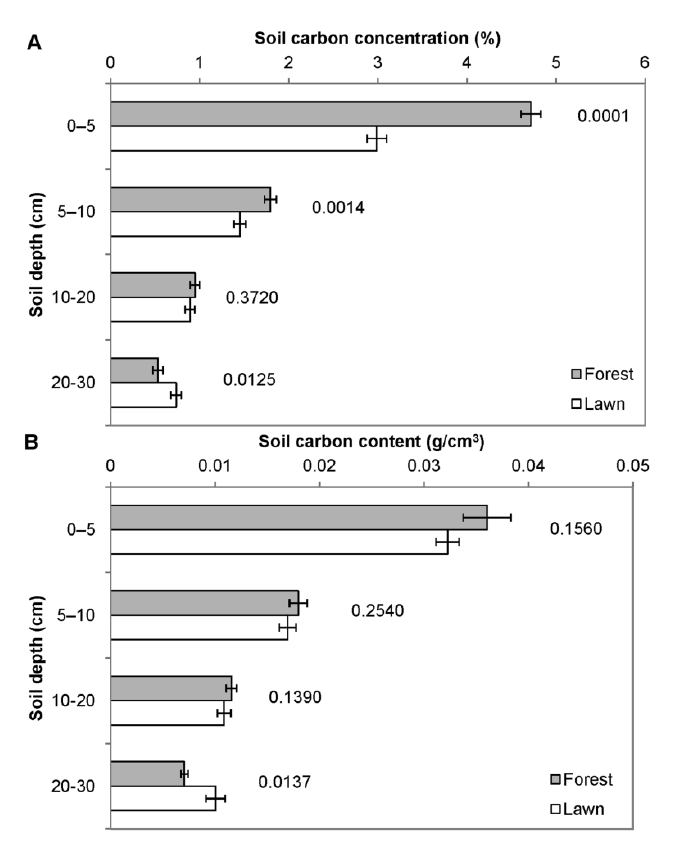
Figure 1. Mean soil C concentration ( A ) and content ( B ) with SE shown at four soil depths in mixed oak forests and adjacent residential lawns in the Valley and Ridge physiographic province of southwest Virginia. P-values are indicated to the right of each landcover comparison.